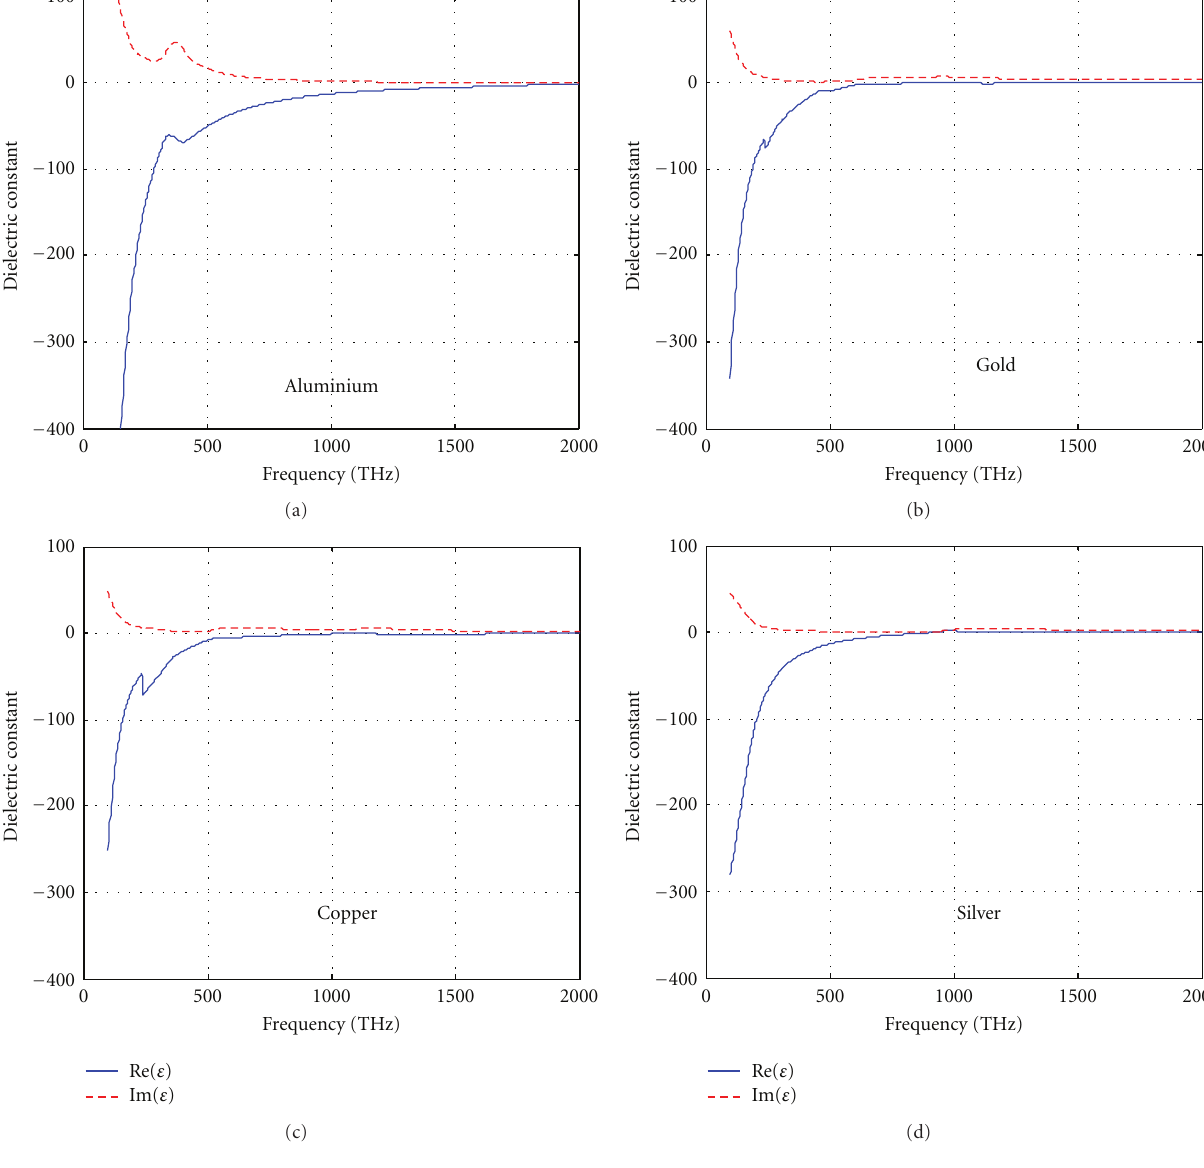
Figure 2: Dielectric constants of (a) aluminum, (b) gold, (c) copper, and (d) silver